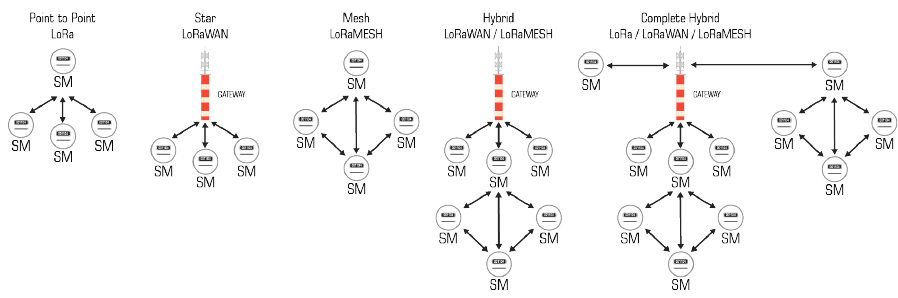
Figure 11. Network topologies to be used in this work adapted from the work